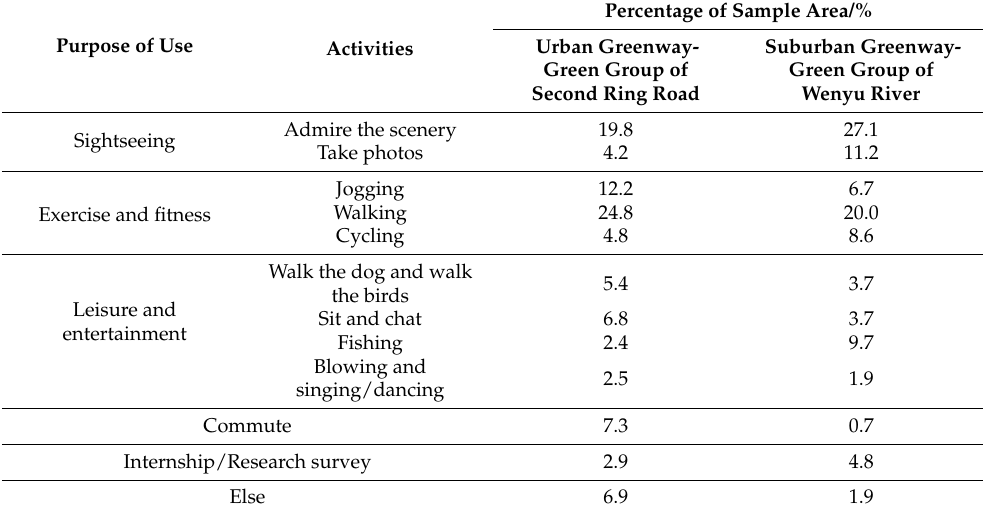
Table 6. Purpose of use and activities.